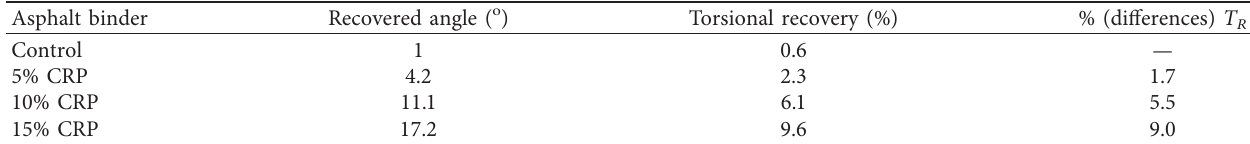
Table 11: Torsional recovery results of CRP modified